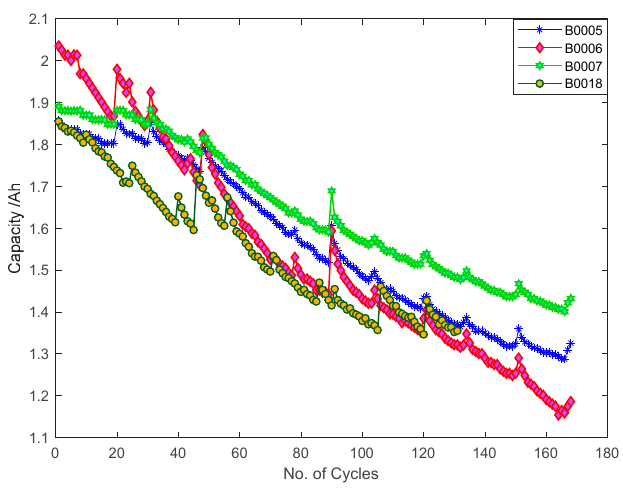
Figure 4. Battery capacity.